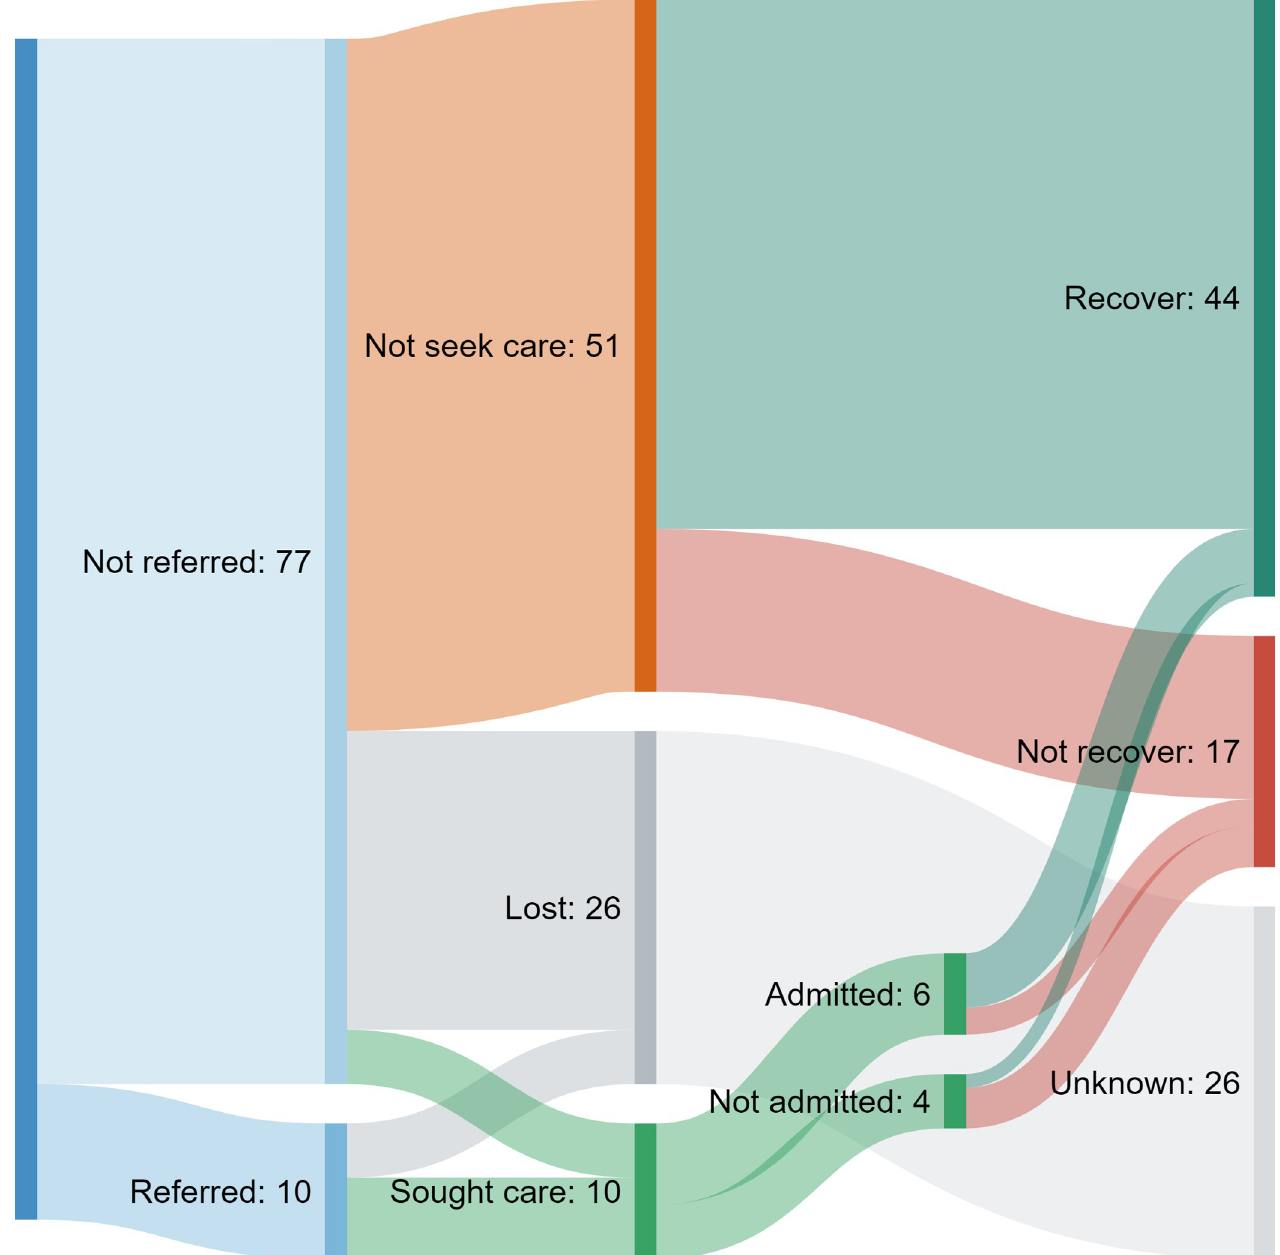
Fig 3. Flow chart showing referral, facility attendance, and day 7 outcomes for 87 children with hypoxaemia SpO2 < 93%. Numbers correspond to the underlying panel and adjacent coloured bar (right) depicting how many participants from one category progressed to the next category. Individual participant care pathways are not